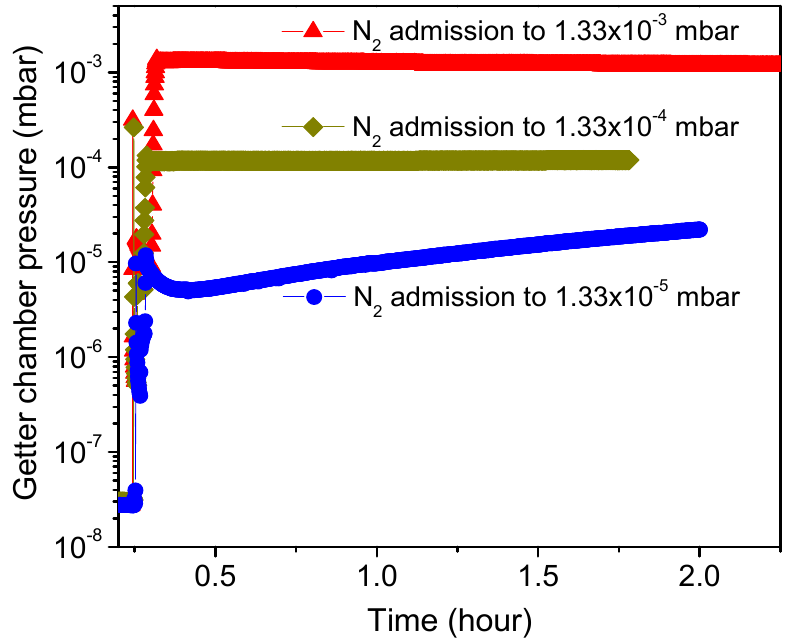
Figure 5. Variation of vacuum chamber pressure without the getter sample (reference test) for N 2 gas admitted into the chamber to different pressure levels.